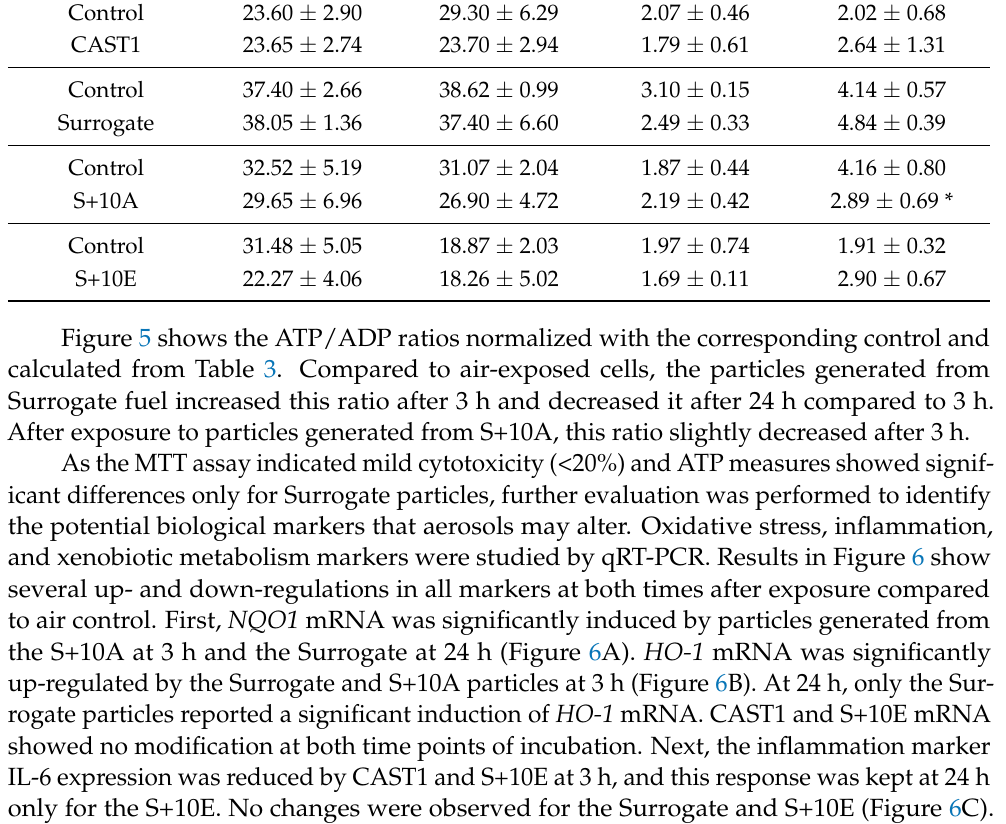
Figure 4. Cytotoxicity determined by MTT assays after 3 h and 24 h of incubation after aerosol exposure. Data are expressed as mean ± SD, n = 4–5 independent experiments, * p < 0.05 vs. control. The effects of emission exposures on ATP and ADP levels compared with air-exposed cells (control) are shown in Table 3. Globally, the levels of ATP remained stable compared to controls. The only significant effect observed was a diminution in the ADP levels after 24 h of incubation with S+10A particles compared to the control ( p < 0.05).